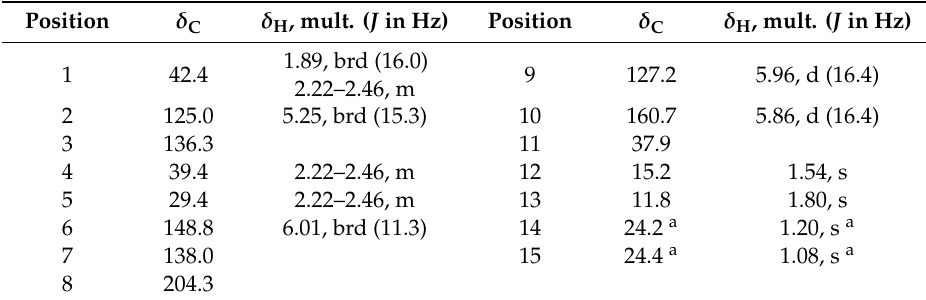
Table 1. NMR spectroscopic data of compound 1 in CDCl 3 .